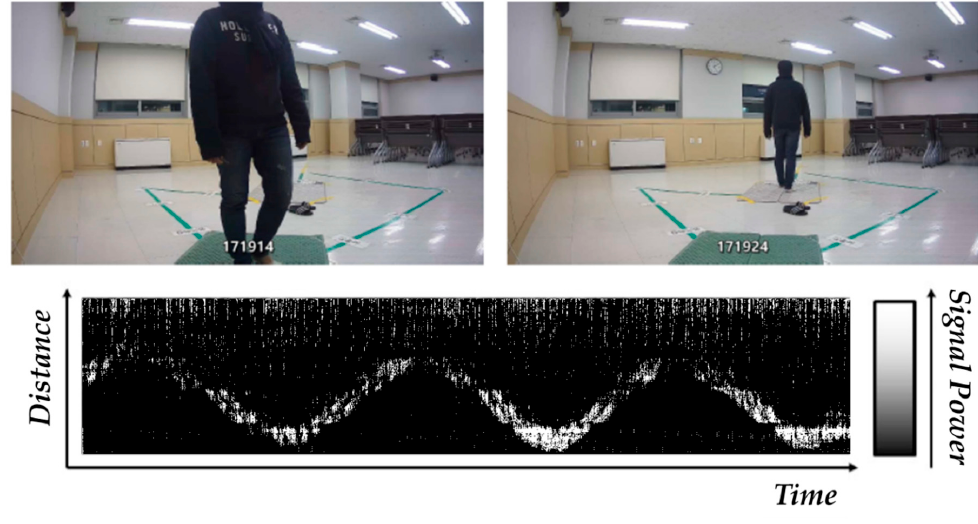
Figure 6. Example of image visualized by preprocessing of IR-UWB data.